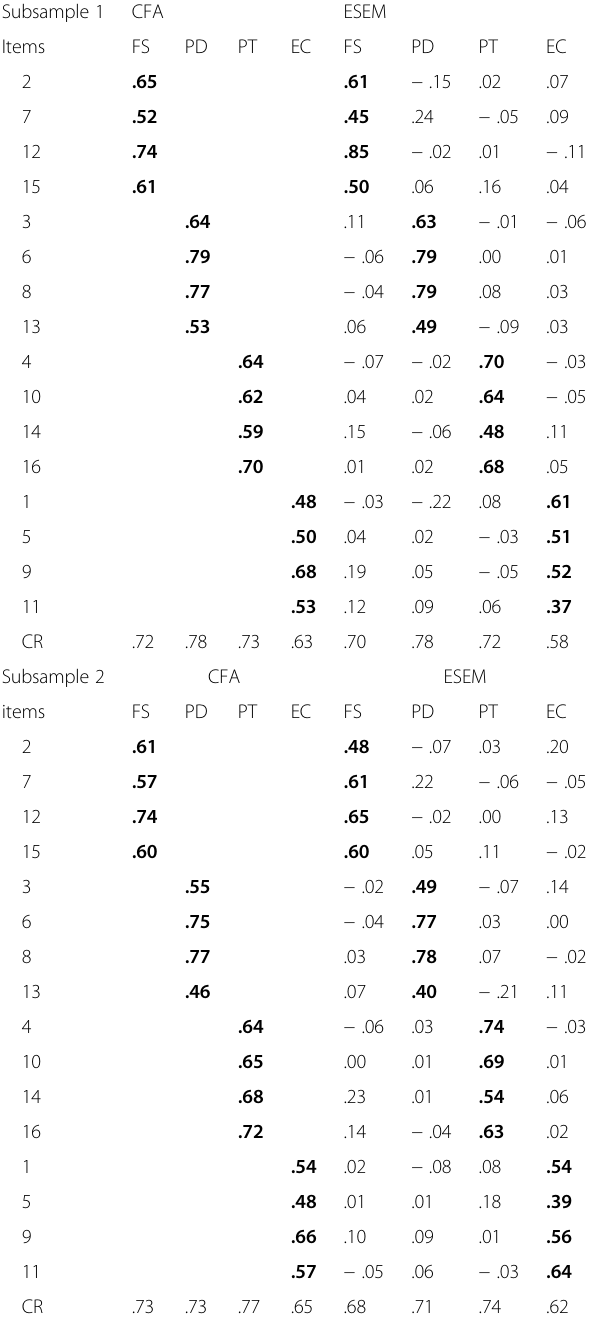
Table 2 Standardized factor loadings and composite